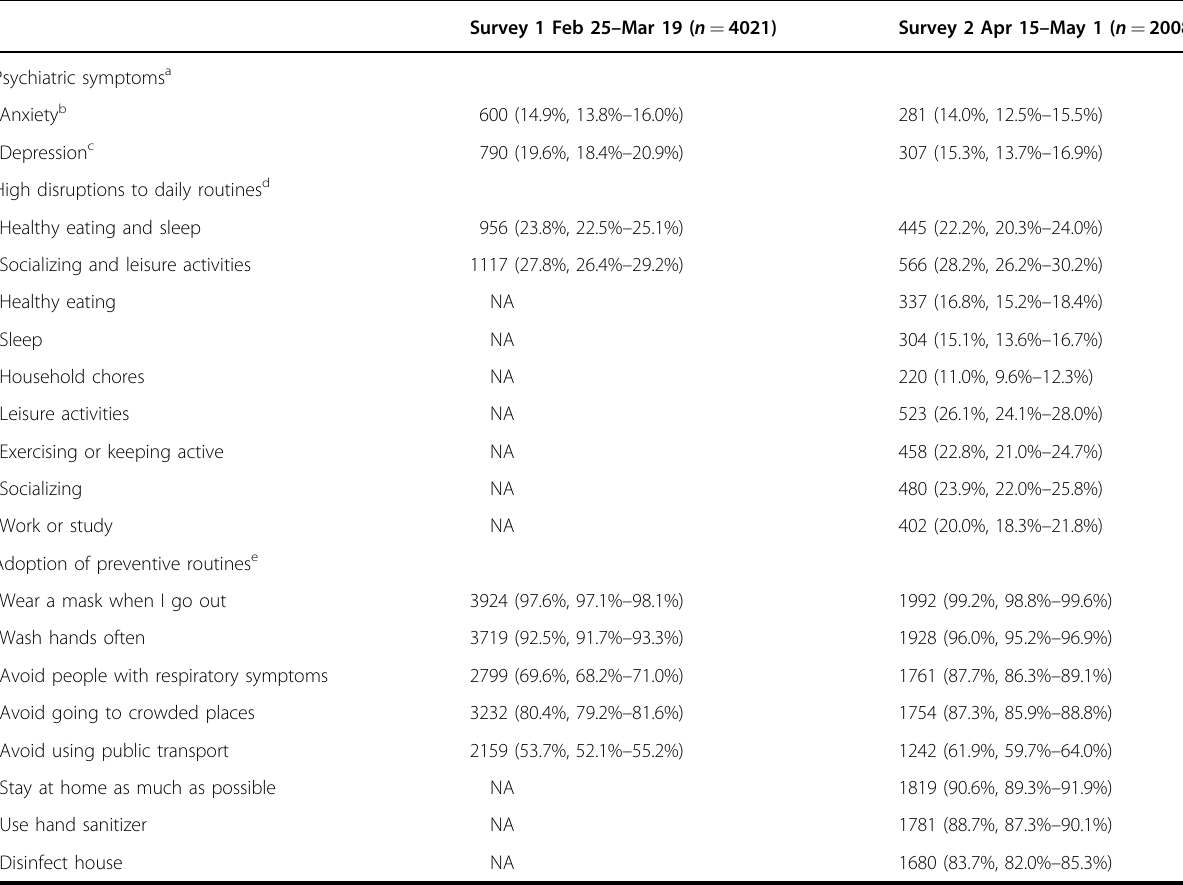
Table 1 Prevalence of anxiety and depression, disruptions to primary and secondary daily routines, and novel preventive